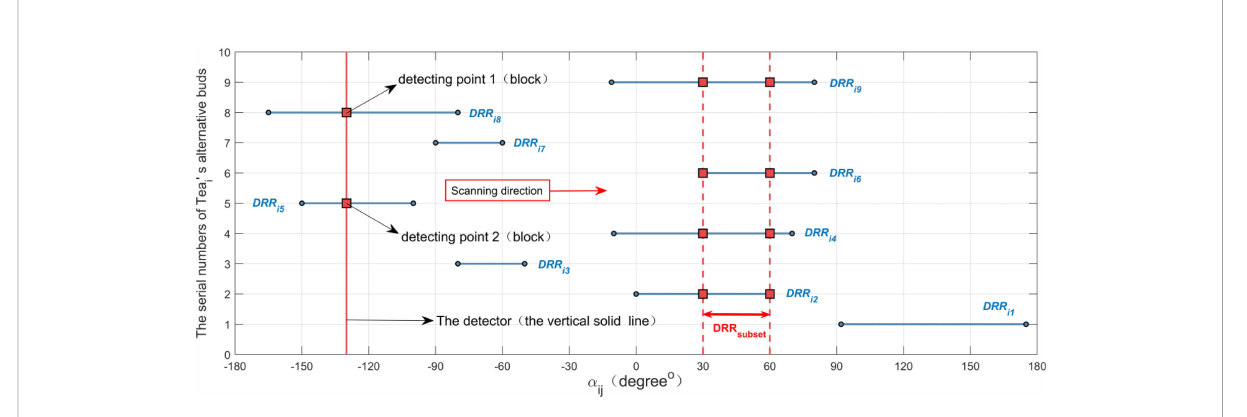
FIGURE 7 Schematic diagram of the interval scanning